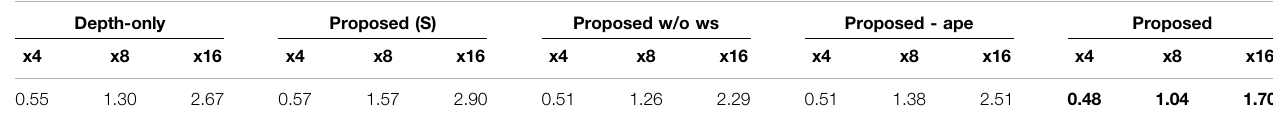
TABLE 7 | Quantitative comparisons of our ablation experiments. Reported results are average RMSE on the noise-free middlebury dataset for scaling factors 4, 8 and 16. Depth-only Proposed (S) Proposed w/o ws Proposed - ape